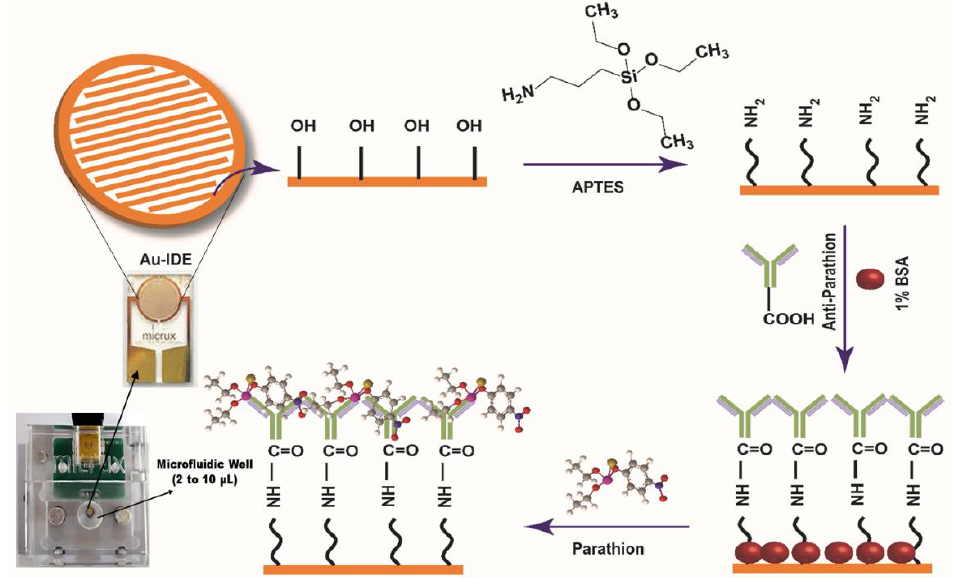
Figure 1. Schematic of stepwise fabrication of immuno-sensor (Anti-PT/Au-IDE).